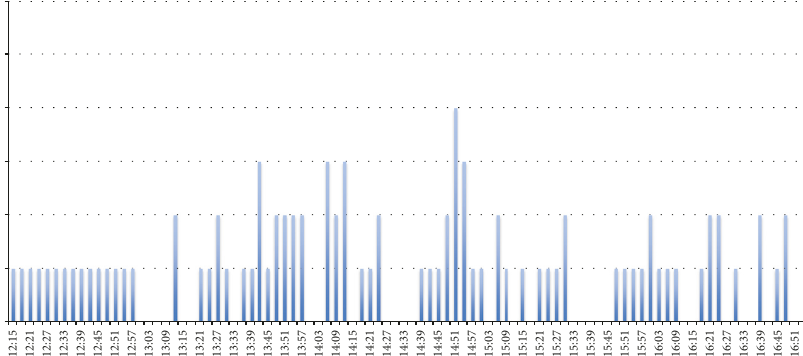
Figure 11: Slots requested by AUs after using UDOM (case study